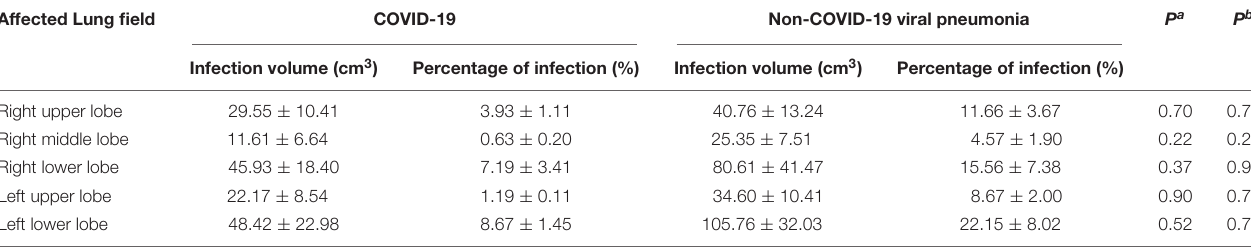
TABLE 3 | Difference in lesions distribution between COVID-19 and non-COVID-19 viral pneumonia patients. Affected Lung